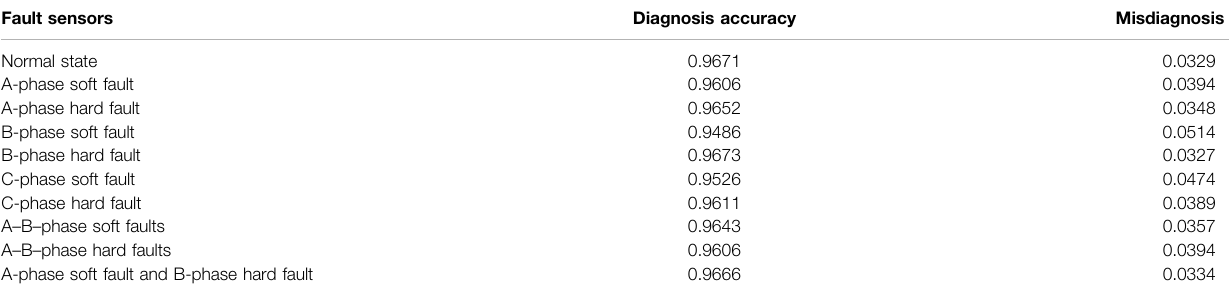
TABLE 3 | Accuracy of RFs with original features.